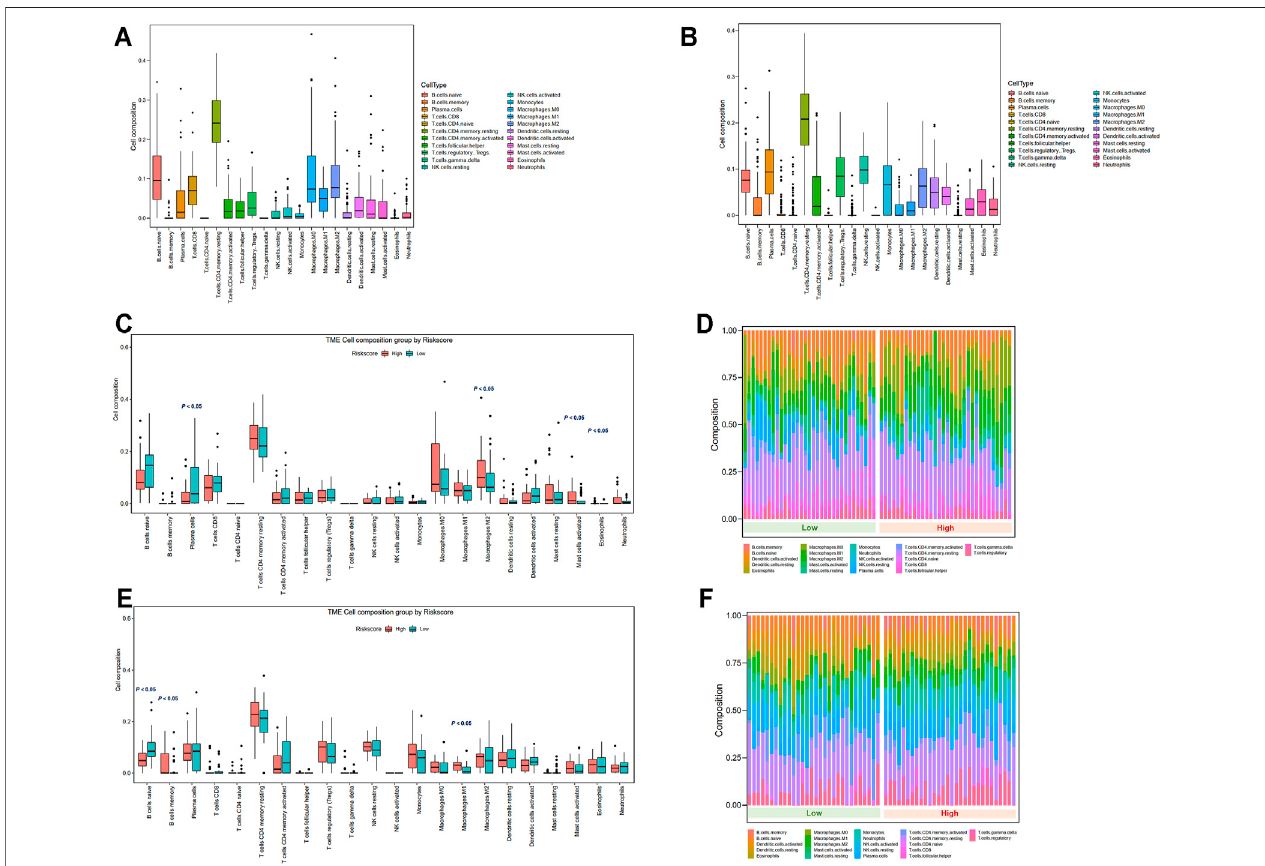
FIGURE 9 | Tumor microenvironment immune cell composition in low- and high-risk groups. (A) Overview of immune cell composition in the TCGA cohort. (B) Overview of immune cell composition in the GSE13898 cohort. (C, D) Differences in immune cell composition in the TCGA cohort classi fi ed by risk groups by Wilcoxon test. (E, F) Differences in immune cell composition in the GSE13898 cohort classi fi ed by risk groups by Wilcoxon test.